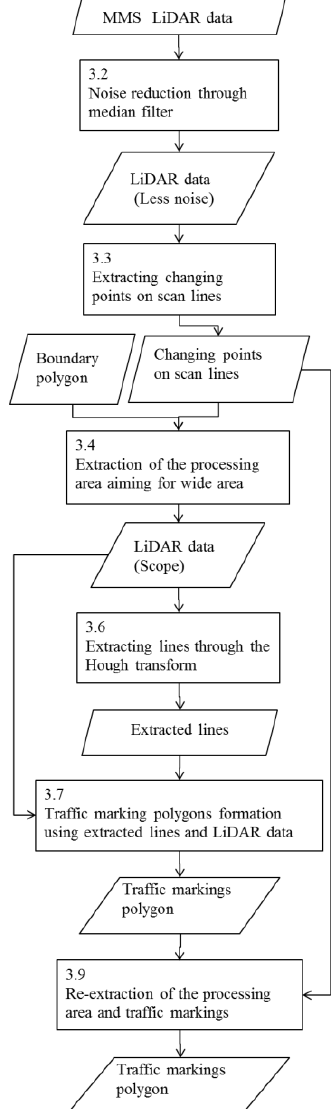
Figure 5. Flow chart of the whole